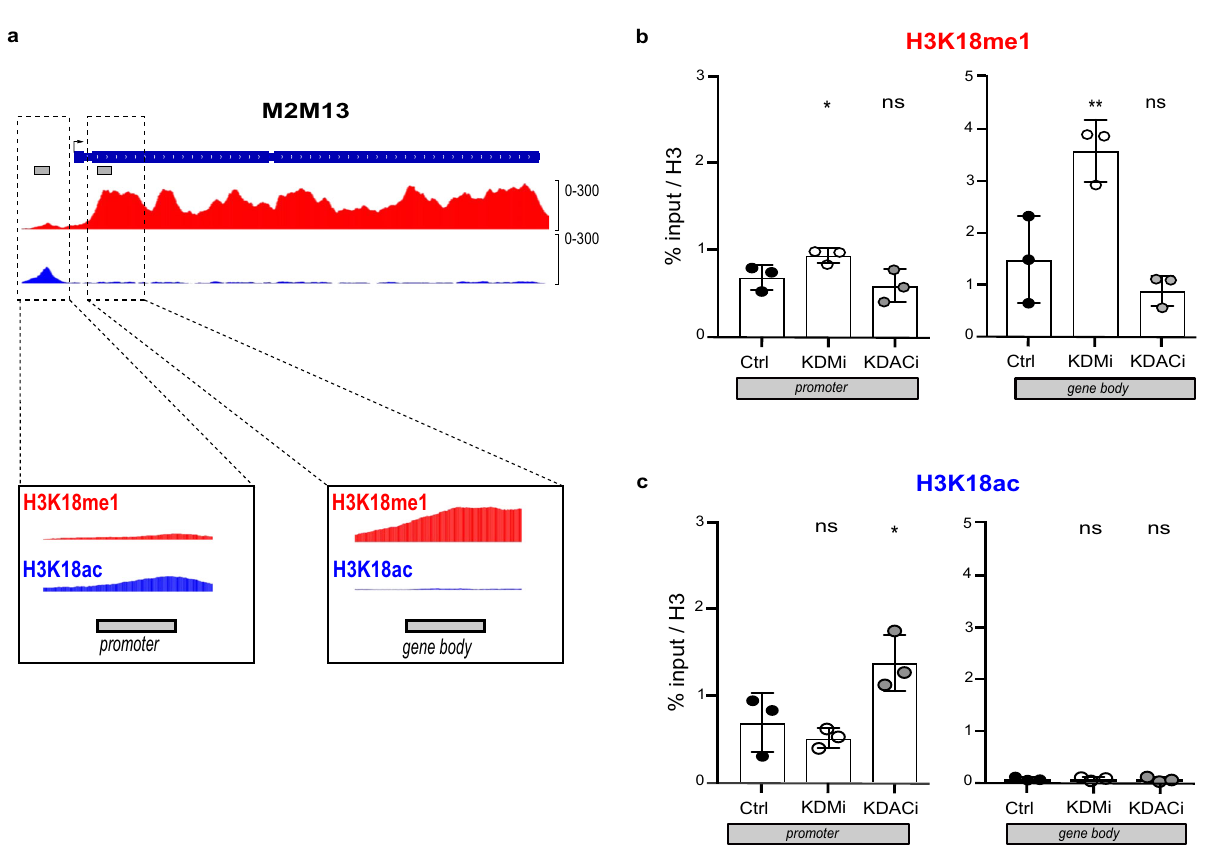
Fig. 5 Chromatin analysis of a differentiation gene. a Representation of the chromatin status of H3K18 at the M2M13 locus. Chromatin immunoprecipitation ChIP-Seq analysis of the M2M13 gene in schizont conditions (37°C) showing H3K18Ac enrichment (blue) on the M2M13 promoter region and H3K18me enrichment (red) on the gene body. b Treatment with the KDMi or KDACi inhibitors impacted the presence of H3K18me1 histone marks on the M2M13 gene. Quanti fi cation of the H3K18me1 mark by ChIP-PCR on the M2M13 promoter or gene-body, after treatment with epigenetic inhibitors. c Quanti fi cation of H3K18ac mark on the M2M13 gene and promoter following inhibitor treatment. For all experiments n = 3 biologically independent experiments of ChIP qPCR. Error bars represent mean values±SD. Statistical test Dunnett ’ s multiple comparison test: ns = not statistically signi fi cant p = 0.2979; ** p = 0.047; * p =